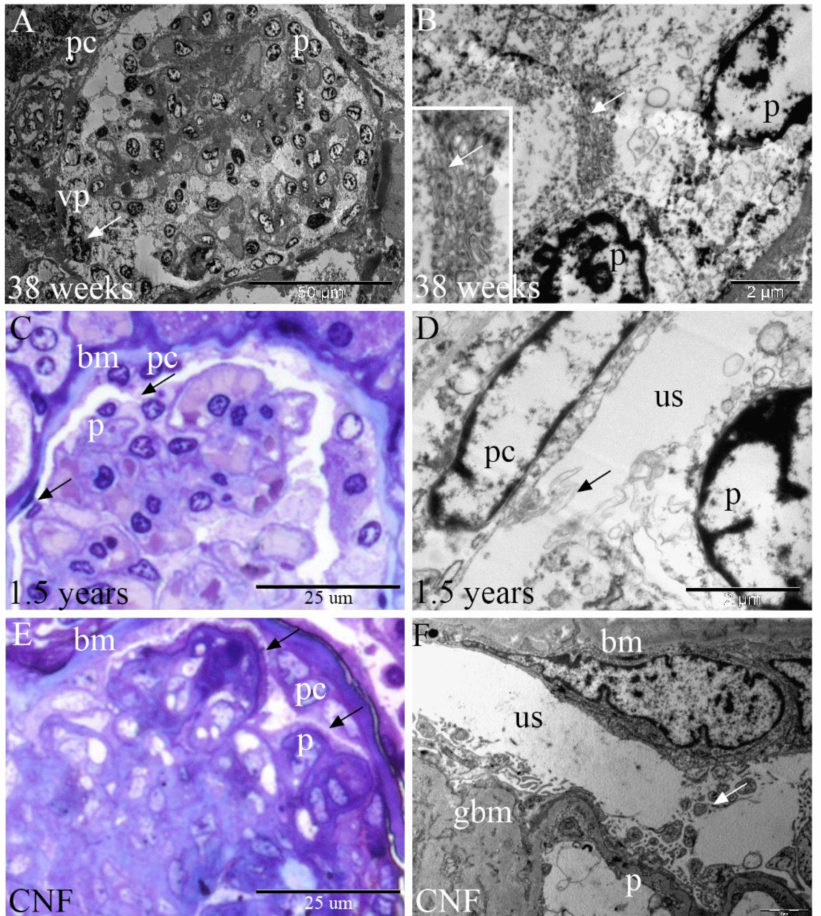
Figure 1. Semi-thin and ultrastructural sections show ultrastructural characteristics of late fetal, postnatal, and CNF kidneys. podocytes (p), PECs (pc), vascular pole (vp), basement membrane (bm), urinary space (us), and glomerular basement membrane (gbm). ( A ) 38th developmental week; glomerular tuft podocytes and PECs widely communicate (arrow) at the vascular pole. ( B ) 38th developmental week; numerous interdigitating cytoplasmic processes (inset, arrows) connect adjacent podocytes. ( C ) Postnatal healthy kidneys; podocytes communicate by cellular bridges (arrows) with PECs. ( D ) Postnatal healthy kidneys; long cytoplasmic extensions of podocytes and PECs bridge (arrow) the urinary space. ( E ) CNF kidneys; podocytes and PECs are connected by cytoplasmic extensions or by closely apposed cellular areas (arrows). ( F ) CNF kidneys; podocytes send numerous thick cytoplasmic extensions (arrow) through the urinary space towards the